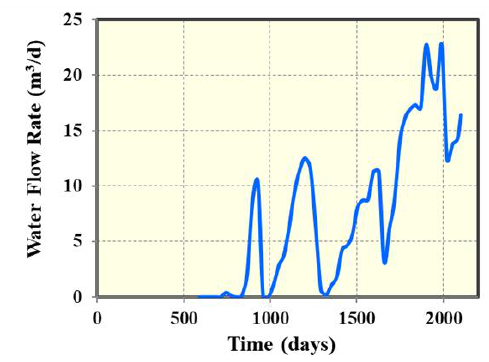
Figure 23. Actual water intrusion trend of well B3.